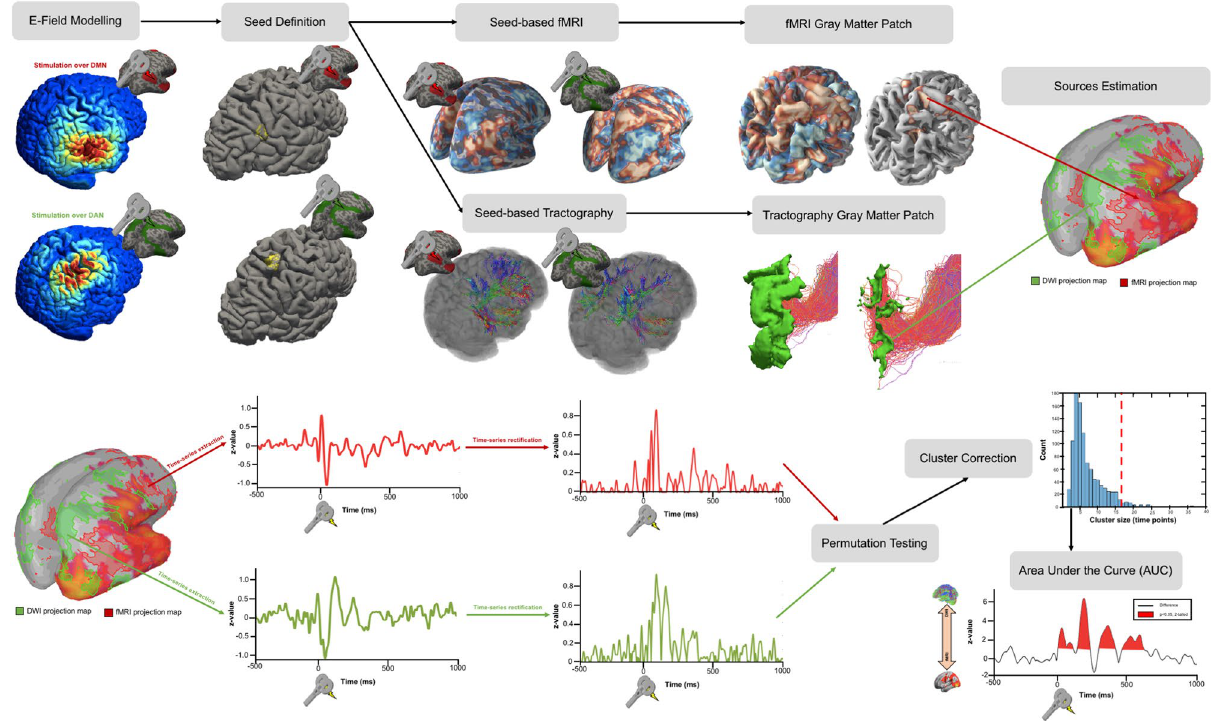
Figure 1. Methodological workflow and features extraction. TMS-induced electric field was modelled with SimNIBS 16 . Fiber tractography and resting state functional connectivity (rs-FC) were computed from the point with the maximal E-field. As for rs-FC analysis, the final maps were obtained z-transforming, thresholding and FDR-correcting the raw connectivity profile. As for tractography, the reconstructed tract was used to threshold the grey matter map where only the voxels reached by a streamline were retailed. The final rs-FC map and the tract-thresholded gray matter were used to extract the source reconstructed EEG timeseries in order to establish which between functional and structural connectivity mostly predict the TMS-induced signal propagation. The EEG signal was projected at source level using the minimum norm estimation (MNE) method with current density and constraining source dipoles to the cortical surface. The raw time series were first rectified 17 and then a baseline bootstrapping procedure 18 was applied. Then, 1000 permutation t-test were performed in which the surrogated DWI vs rs-FC difference was computed after each iteration and statistically compared with the real difference 19 . Finally, the cluster threshold was determined as the 95th percentile of the cluster’s surrogate distribution and the area under the curve (AUC) of the significant clusters was extracted within the 350 ms post-TMS period, with positive and negative values indicating that the TMS-EEG signal propagated more on DWI or fMRI projection map, respectively. For further details on TMS-induced electric field modelling please refer to Supplementary Materials and Methods. For a visualization of the individual white matter bundle of both DAN and DMN please see Supplementary Figs. S2 and S3. No software was used to generate this MRI data acquisition. The MRI evaluation was performed on a 3 T scanner (GE Healthcare, Ltd., United